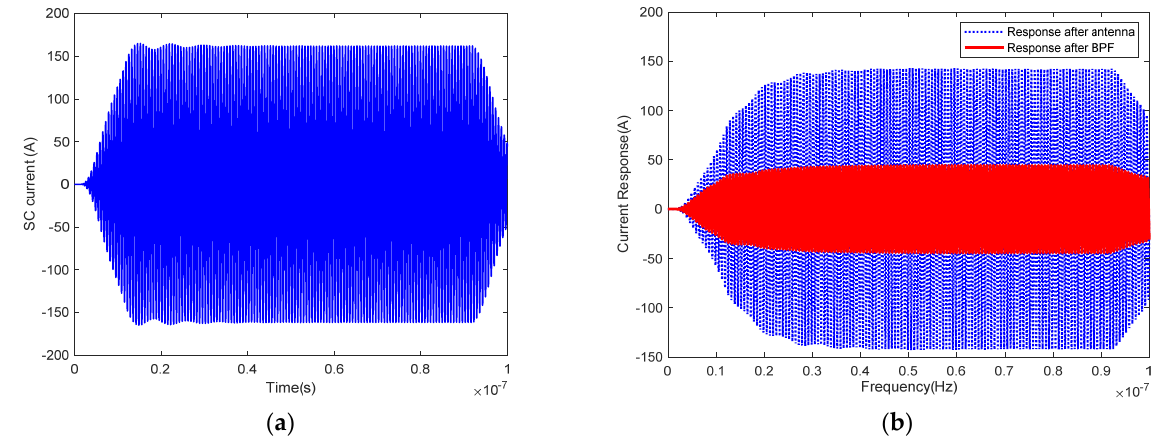
Figure 16. Coupling response excited by UWB: ( a ) Isc current; ( b ) Responses.